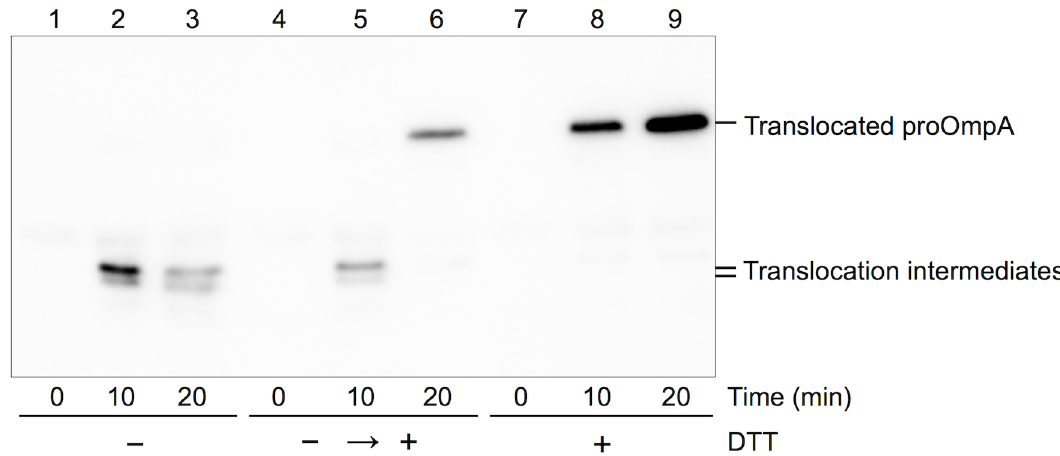
Fig 3. Detection of protein translocation intermediate derived from SecYAEG-reconstituted liposomes and proOmpA(L59) mutant. The intermediate states were generated using proOmpA(L59) mutant. The protease-resistant regionof proOmpA in the intermediate states was detected by newly obtainedanti-proOmpA 38-54 immunoblotting under non-reducing conditions. Translocation was re-initiatedupon additionof DTT, a reductant.